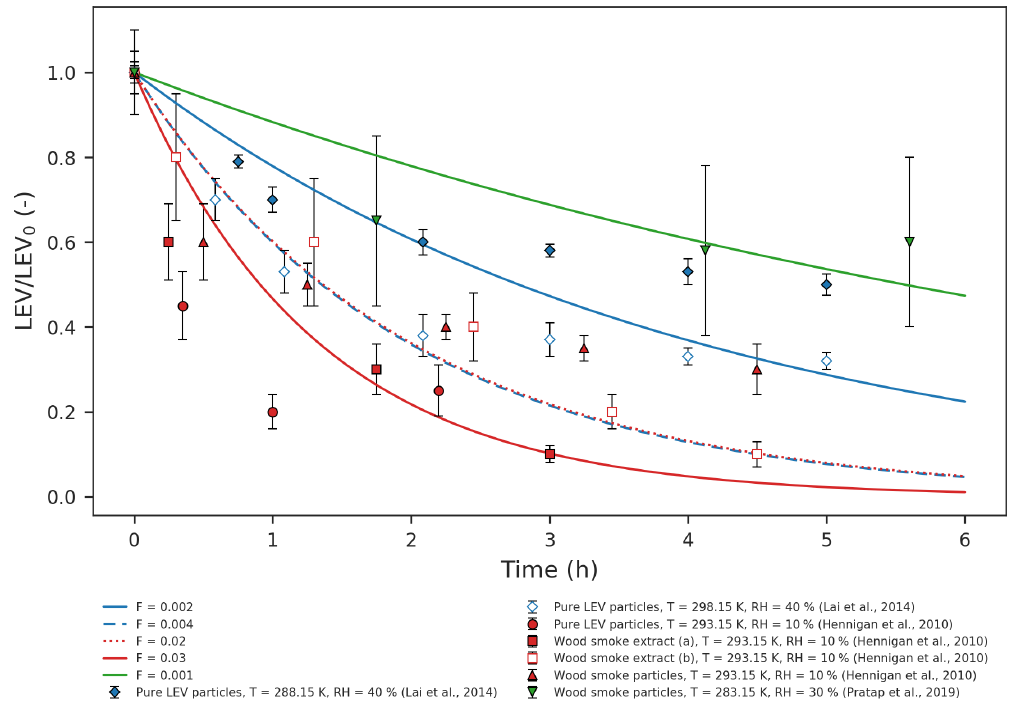
Figure 1. Simulated LEV degradation (lines) and measured LEV degradation (points); colors represent conditions from different chamber experiments taken from three studies (red – Hennigan et al., 2010; blue – Lai et al., 2014; green – Pratap et al., 2019) used in the simulations. LEV concentration is normalized by the initial concentration (LEV/LEV 0